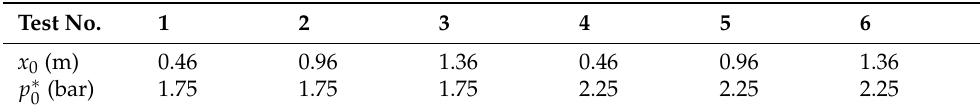
Figure 8. Experimental facility.